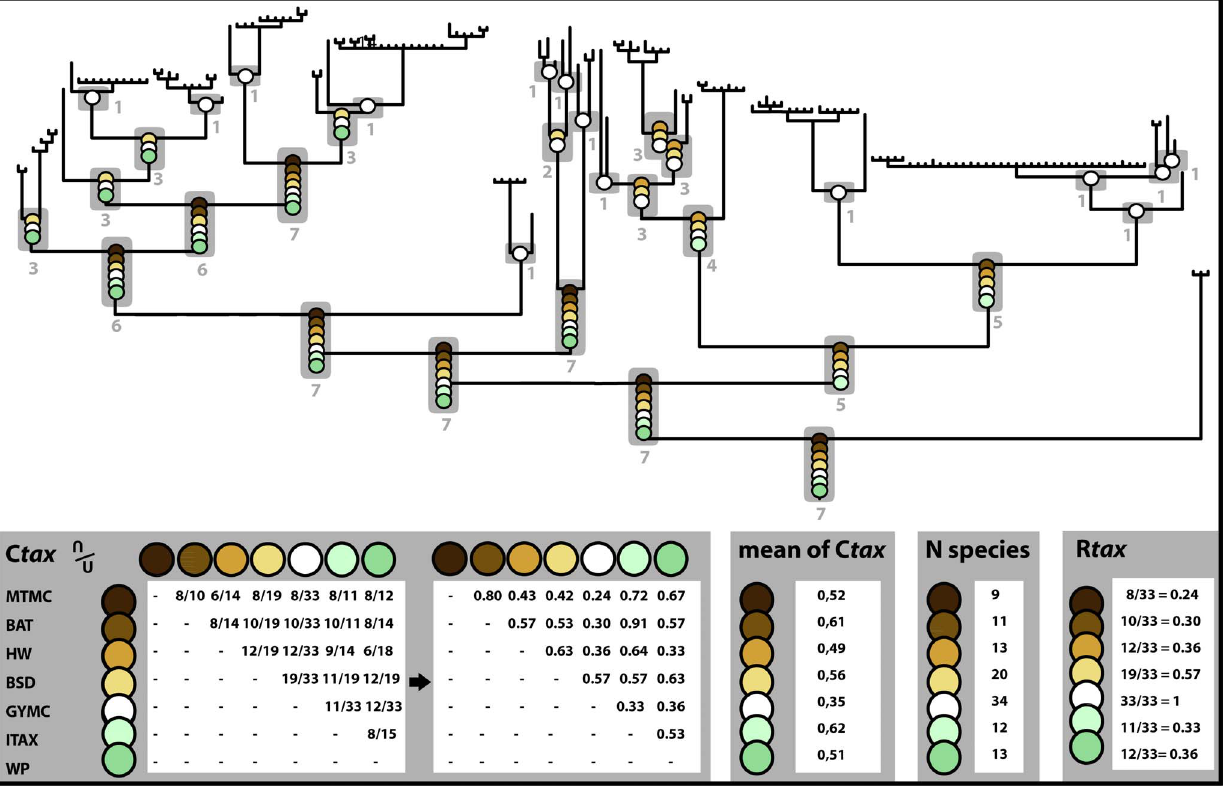
Figure 7. Relative taxonomic resolving power index (R tax ) and Taxonomic index of congruence (C tax ) calculation for each species delimitation approaches tested. Each putative speciation event inferred by all seven approaches (cf. Fig. 2) is reported for better visualization on the mtDNA tree topology (although these indices can also be understood without relying on a specific tree topology). Each color represents a distinct method. The R tax of a given approach represents the proportion of speciation events that are really supported by this approach, among the complete set of speciation event hypotheses (set of boundaries cumulatively revealed by different approaches. The C tax between two approaches is defined as the ratio of the total number of speciation events congruently supported by both approaches, to the total number of pairwise species boundaries cumulatively supported by both approaches. The mean C tax value (mean of all C tax values involving each of these approaches) and the number of species supported by each approaches is also presented.